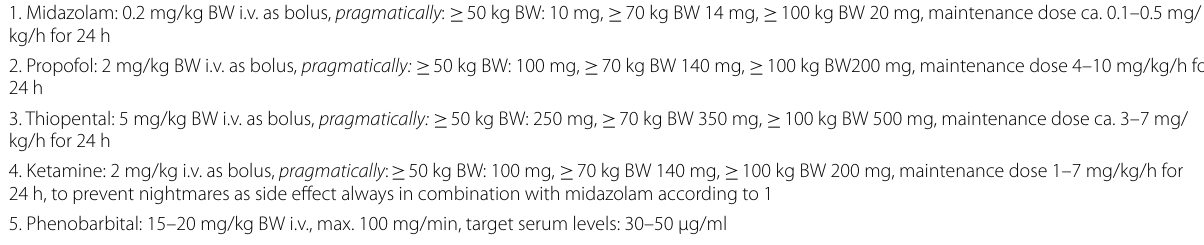
Table 1 Dosages of intravenous anesthetics, adopted and modified from